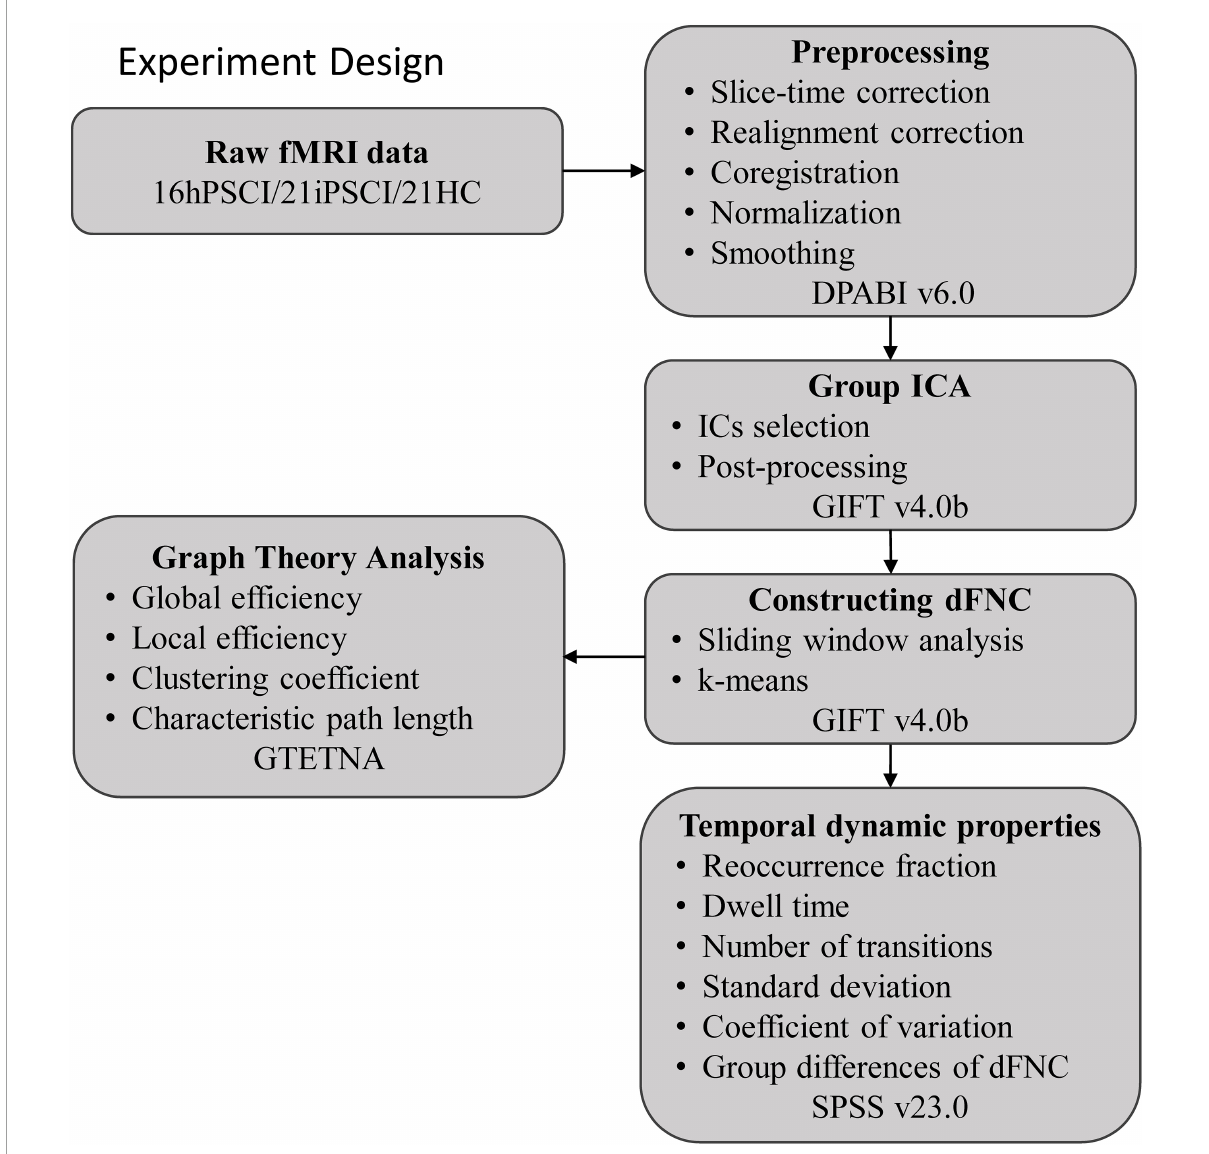
FIGURE1 The entire experimental design processing flow. hPSCI, cognitive impairment group after hemorrhagic stroke; iPSCI, the cognitive impairment group after ischemic stroke; HC, health control group; ICA, independent component analysis; dFNC, dynamic functional network